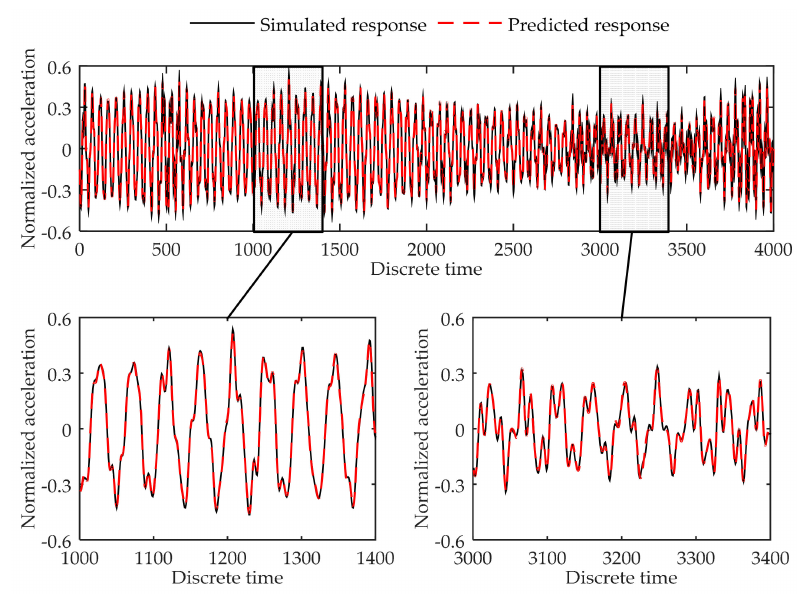
Figure 4. Comparison between the predicted response and simulated response of the 4th degree of freedom at the 6-DOF system in validation dataset. Table 4. Testing error of Load Cases 1-1 to 1-6.